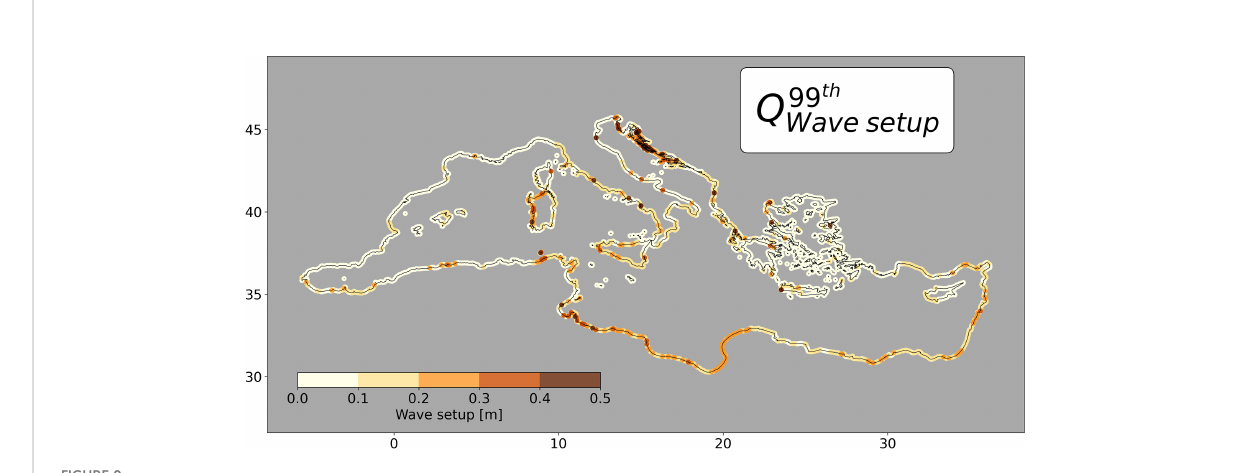
FIGURE 9 Wave setup ( elev coupled - elev ) 99 th quantile of sea surface elevation of independent events (see section 2.3) for coastal grid points within the Mediterranean